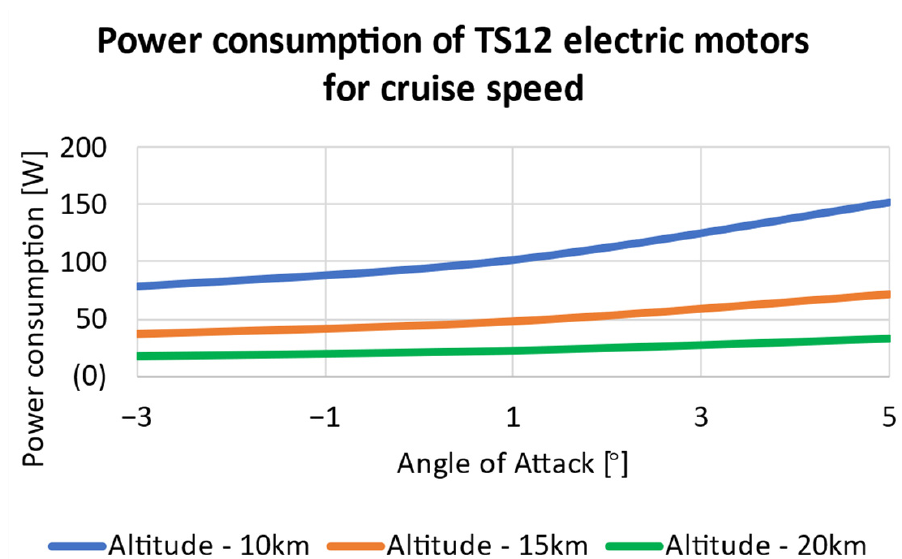
Figure 22. Power consumption of TS12 electric motors for cruise speed.